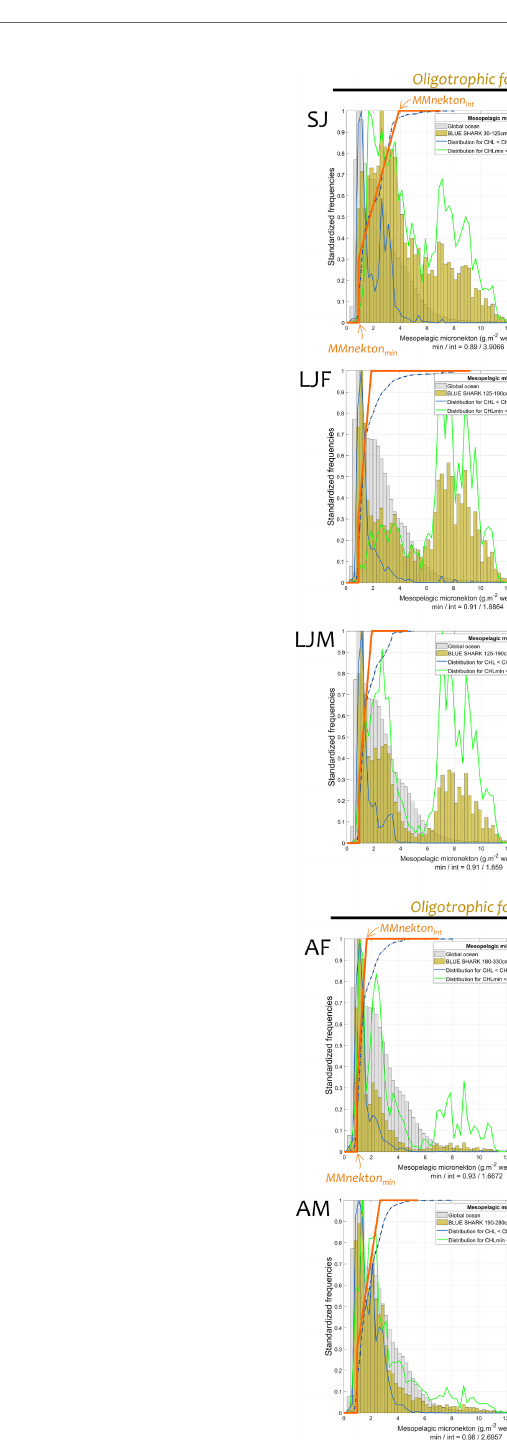
FIGURE 3 | Frequency of blue shark presence in each foraging proxy (colored histograms, relative units) and identi fi cation of the respective daily linear function of foraging habitat (orange line segment). The distribution of mesopelagic micronekton (oligotrophic foraging, the colored histogram on left panels; MMnekton ; g.m -2 wet weight) and chlorophyll-a gradient (mesotrophic foraging, the colored histogram on the right panels; gradCHL ; log-transformed, mg.m -3 .km -1 ) at the location of blue shark presence data by size and sex classes (SJ, LJF, LJM, AF, and AM) are compared to the global ocean distribution (light grey histogram). The distribution of MMnekton and gradCHL at the location of blue shark presence and for CHL < CHL min and CHL min < CHL < CHL max , respectively, are delineated by the blue and green lines. The maximum slope of the cumulative distribution of blue shark presence for each foraging proxy (blue and green dashed line for MMnekton and gradCHL , respectively) de fi nes the slope of the daily habitat linear function (orange line; see also Table 1 ; also using MMnekton min and gradCHL min